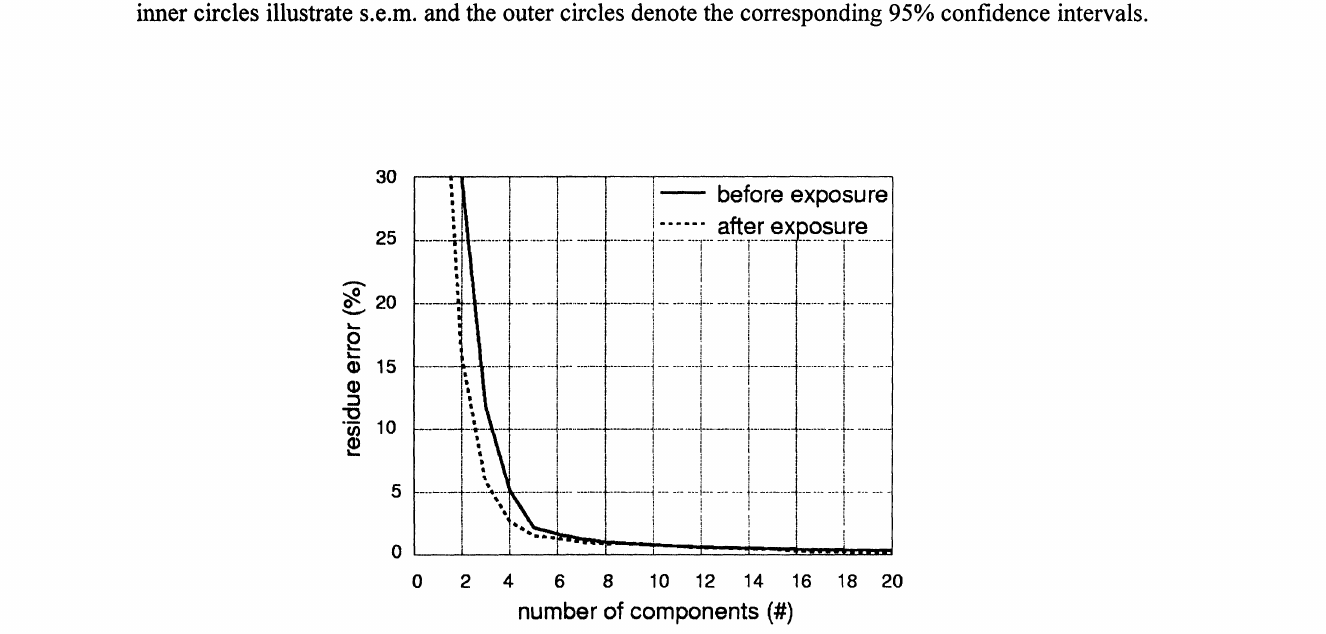
Fig. 5: Results of ICA analysis from a dataset of one individual subject. The curves illustrate the number of components necessary to explain the evoked gamma-band activity for different levels of error percentages. Over an entire range of error levels, more components are needed to explain the data before (solid line) than after exposure (dashed